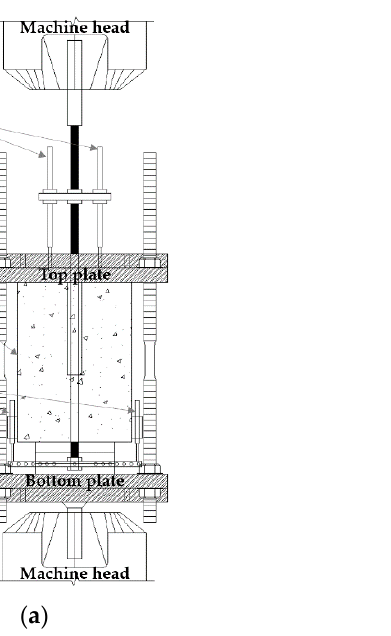
Figure 15. Force in the GFRP bar versus the slip obtained in PN_B_X specimens and in pull-out tests with a 200 mm bonded length.